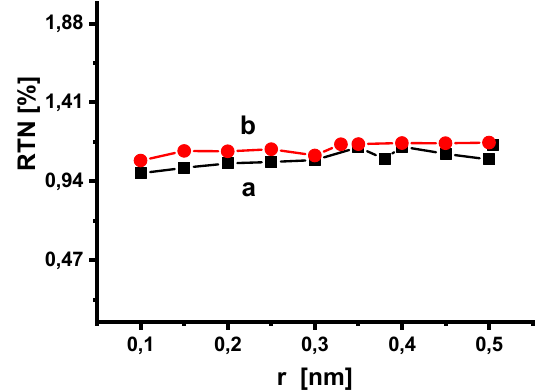
Figure 7. RTN amplitude dependence on the radius of ( a ) the oxide, and ( b ) the interface single charged defects at a constant trapped charge.